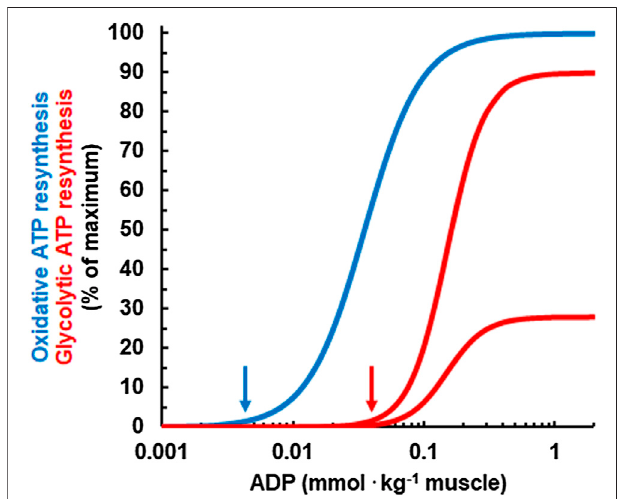
FIGURE 2 | Relationship between the concentration of ADP and the simulated, relative rates of oxidative (blue) and glycolytic ATP resynthesis (red) for a pH of 7 (upper red curve) and for a pH of 6.4 (lower red curve). Note that ADPneedstorisetohigherconcentrationsforglycolyticATPresynthesis tokickinthanforoxidativeATPresynthesis.Thisisanimportantfeatureforthe regulation of human energy metabolism and explains why oxidative ATP resynthesisisdominant atrestandduringlowintensityexercise. Moreover,as anacidpHinhibitsphosphofructokinase,therateofglycolyticATPresynthesis at a given ADP concentration is lower if the pH is in reduced. In the model, the maximal rate of glycolytic ATP resynthesis is reached at a pH of 7.4 which is not shown in the fi